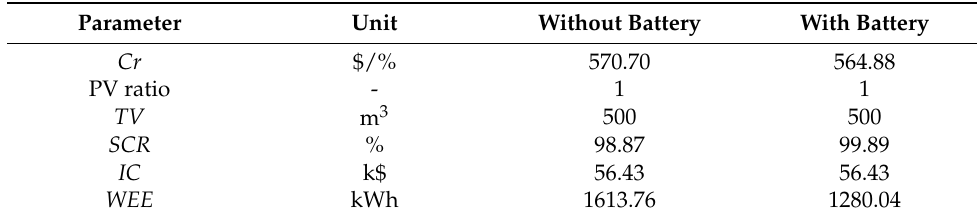
Table 7. Optimal configurations according the combined criterion for Svishtov (wine grapes) with a 15 kW HRES, mSi PV technology and WT type 3.